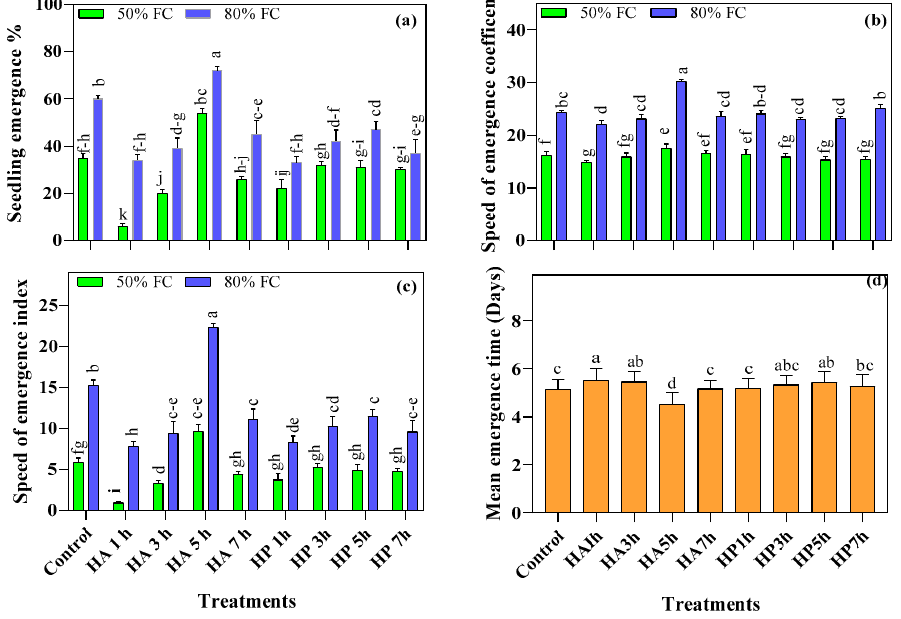
Figure 3. Interaction effect of priming treatments and field moisture level on ( a ) seedling emergence percentage (SEP); ( b ) speed of emergence coefficient (SEC); ( c ) speed of emergence index (SEI) and means (±SE) followed by the same letters do not differ significantly between treatments x field mois- ture level using Ls means at p < 0.05; ( d ) mean emergence time (MET) and means (±SE) followed by the same letter on the bar do not differ significantly based on LSD at p < 0.05. Humic acid (0.2 g/L) priming for 5 h showed higher increment (54.4%) in SEP com- pared with control in water stress condition (50% FC level) while only 20% increment was